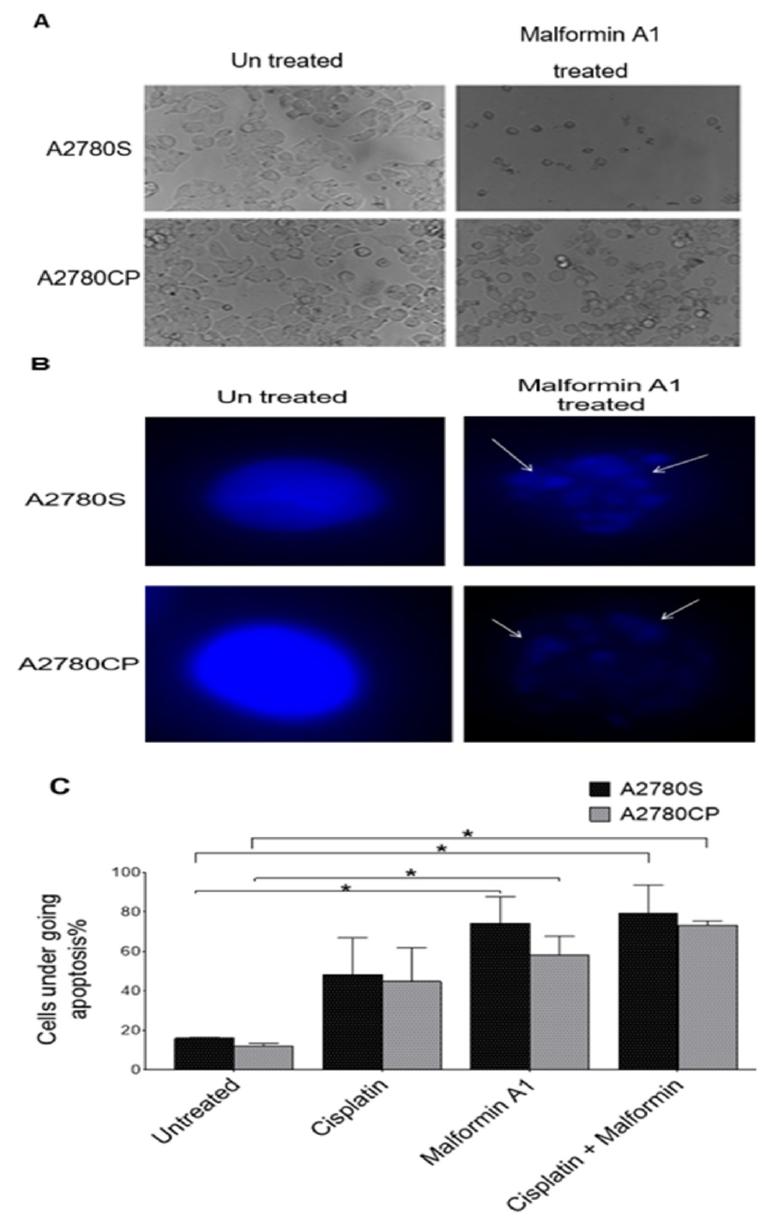
Figure 2. Cells’ morphology changes upon treatment with MA1: ( A ) Morphology of untreated ovarian cancer cell lines and Malformin A1 treated cells; ( B ) the nucleus major changes, as visualized by fluorescent microscopy following Hoechst stain using at 40 × magnification. ( C ) The percentage of affected cells treated with MA1 compared to cisplatin treatments. Manual counts were performed blindly by three experienced observers on randomly selected fields containing at least 200 cells. * p < 0.05